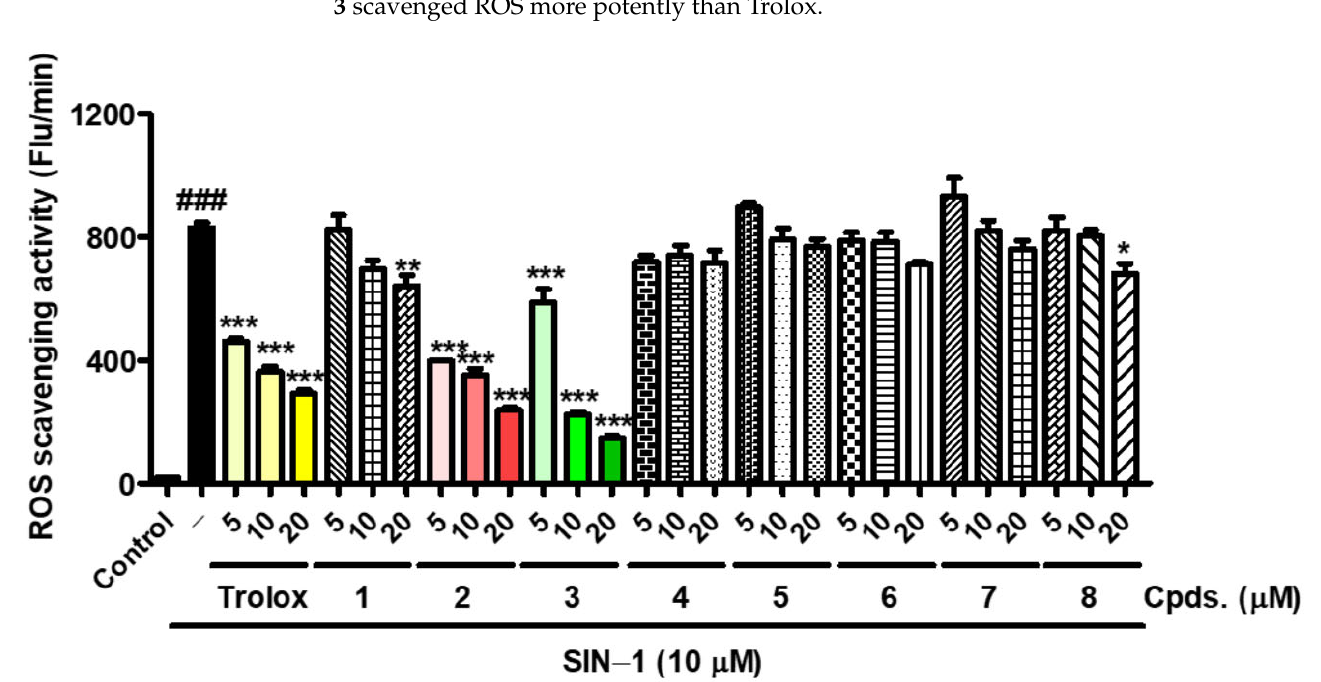
Figure 10. ROS scavenging activities of analogs 1 – 8 . Trolox and SIN–1 were used as the positive control and ROS generator, respectively. SIN–1 was used at a concentration of 10 µ M, and test samples or Trolox were added to final concentrations of 5, 10, or 20 µ M. Experiments were conducted 3 times independently; results are the means ± standard errors of three different experiments. The symbols # and * represent significant differences. ### p < 0.001 for non-treated controls versus SIN–1-treated controls; * p < 0.05, ** p < 0.01, *** p < 0.001 for SIN–1-treated controls versus Trolox or analog plus SIN–1.